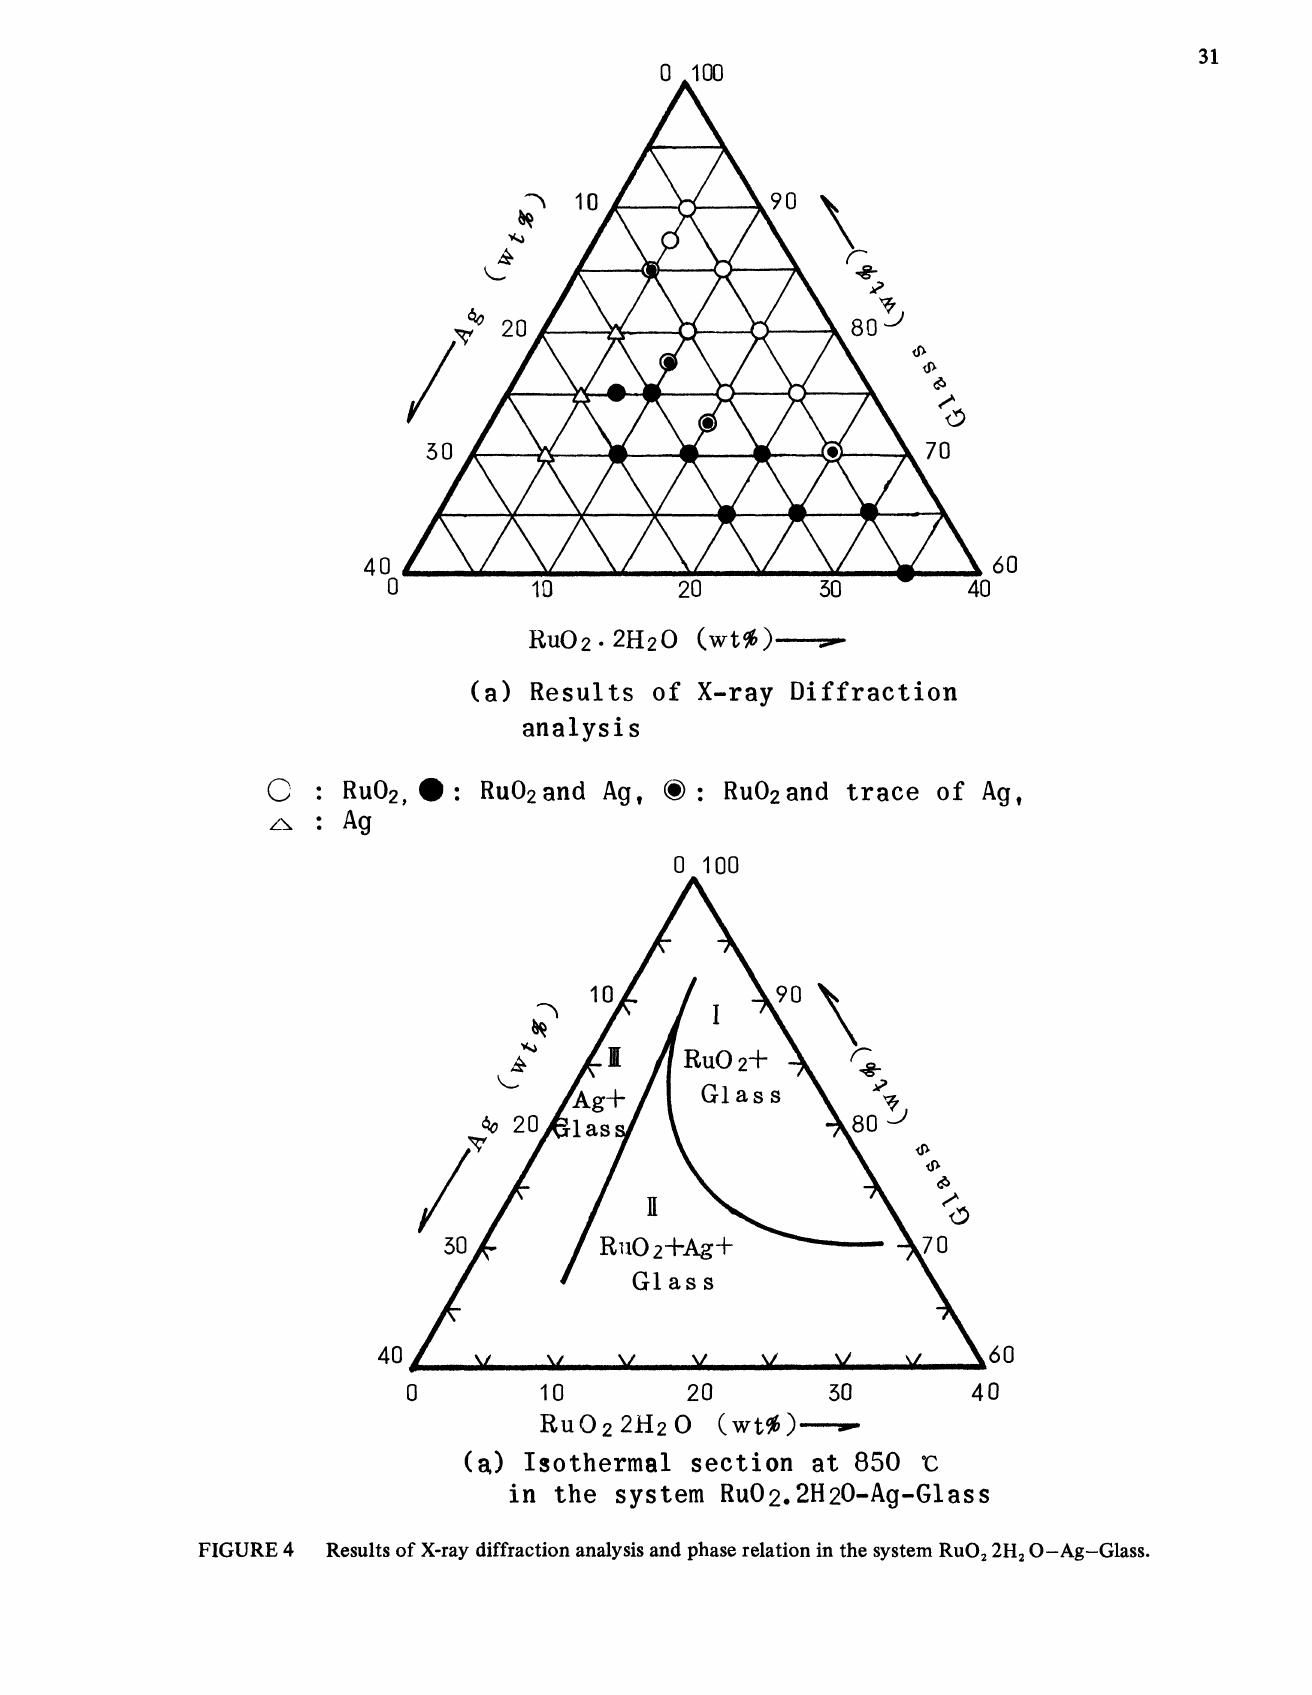
Results of X-ray diffraction analysis and phase relation in the system RuO2 2H